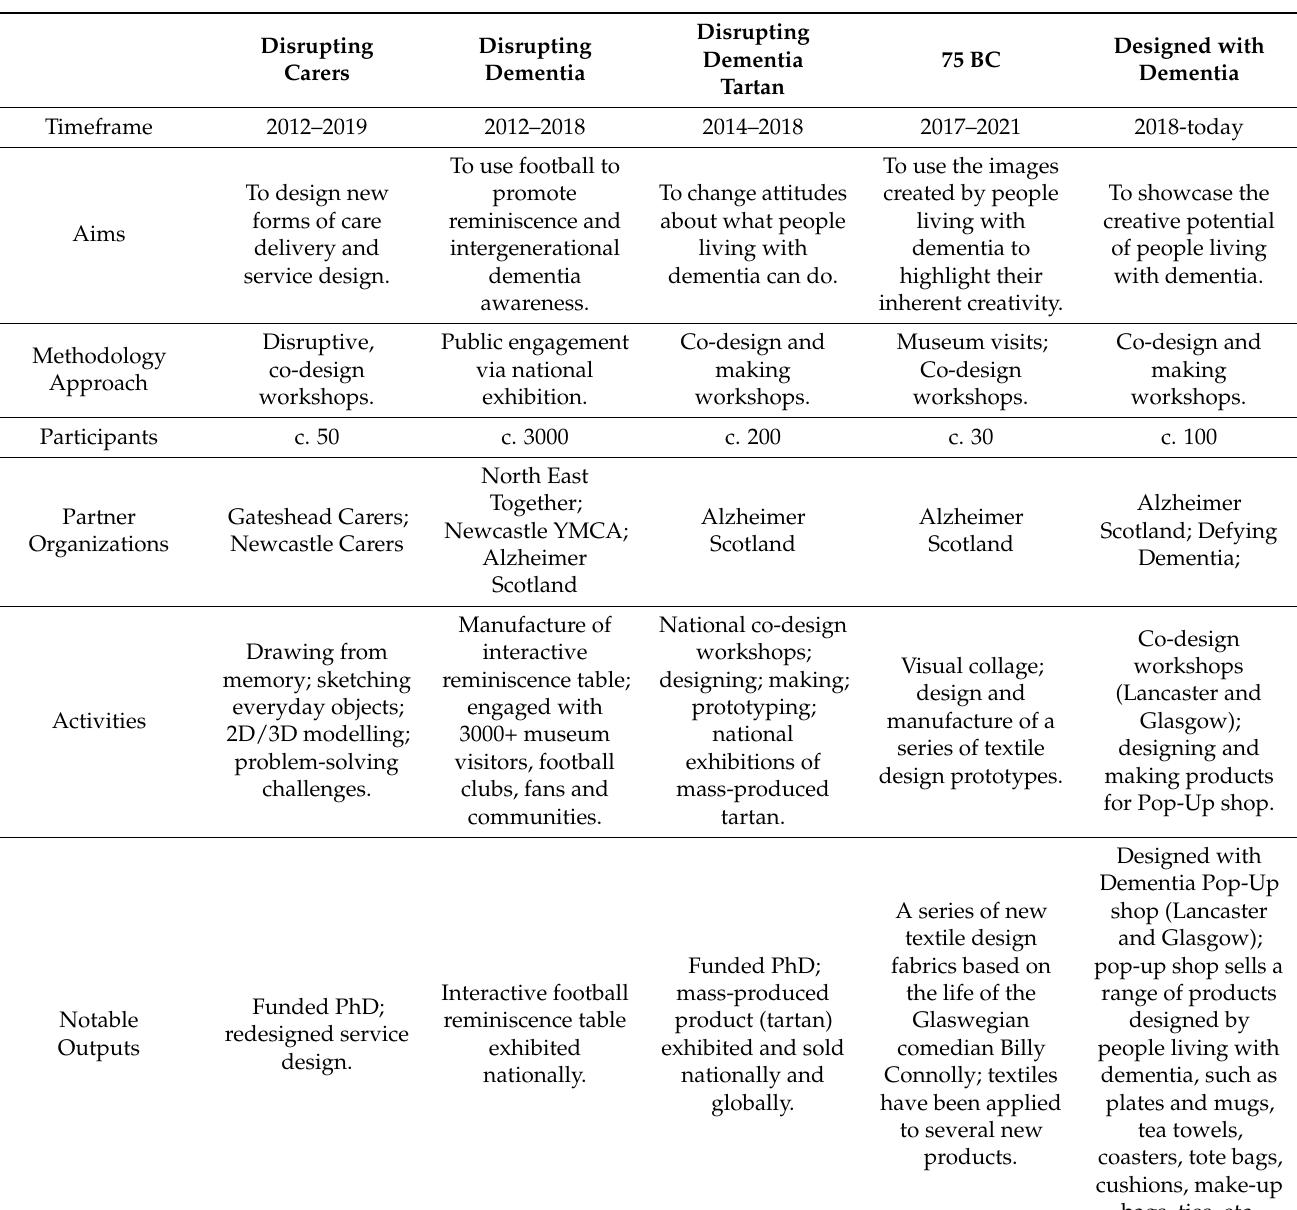
Table 1. Disruptive Design Workshops